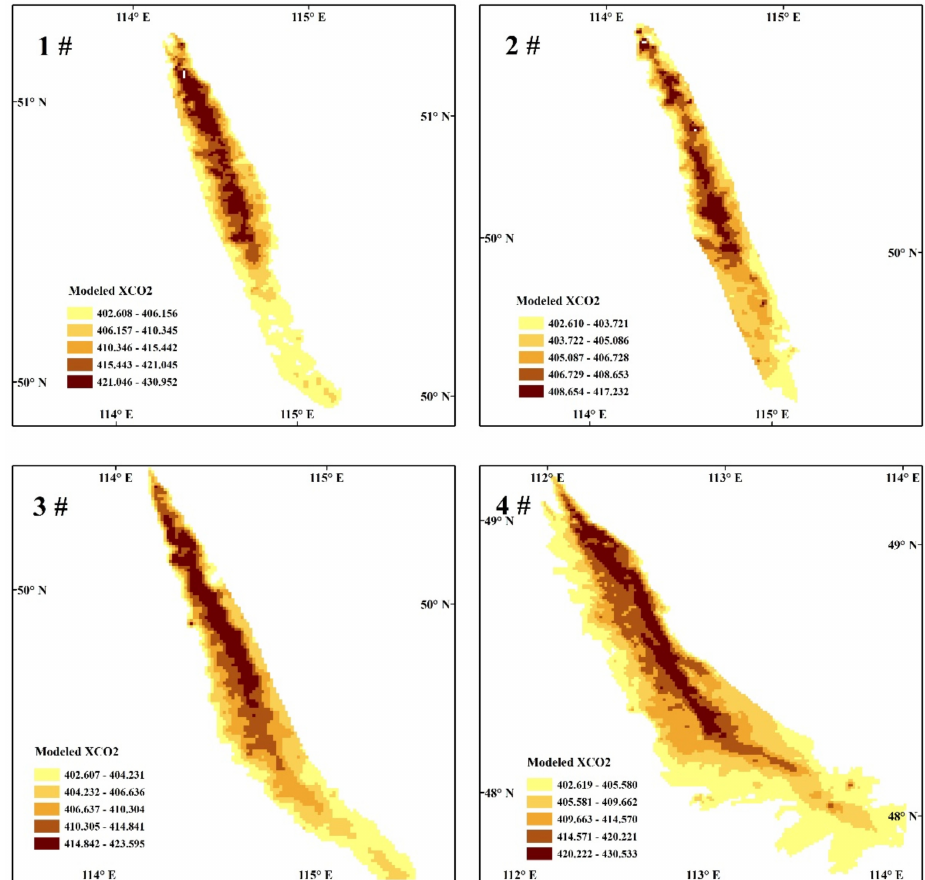
Figure 6. XCO2 values of smoke plumes calculated from MODIS band 8 reflectance.